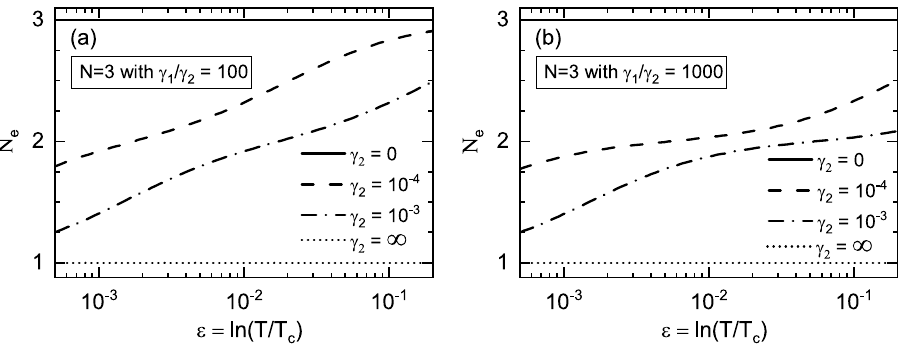
N ≃ 2 . Panel b Same for 𝛾 1 ∕ 𝛾 2 = 1000 , demonstrating an enlarge- e ment of the plateau around N e ≃ 2 (correlated to the softening of the x ≠ 1 features in Fig.